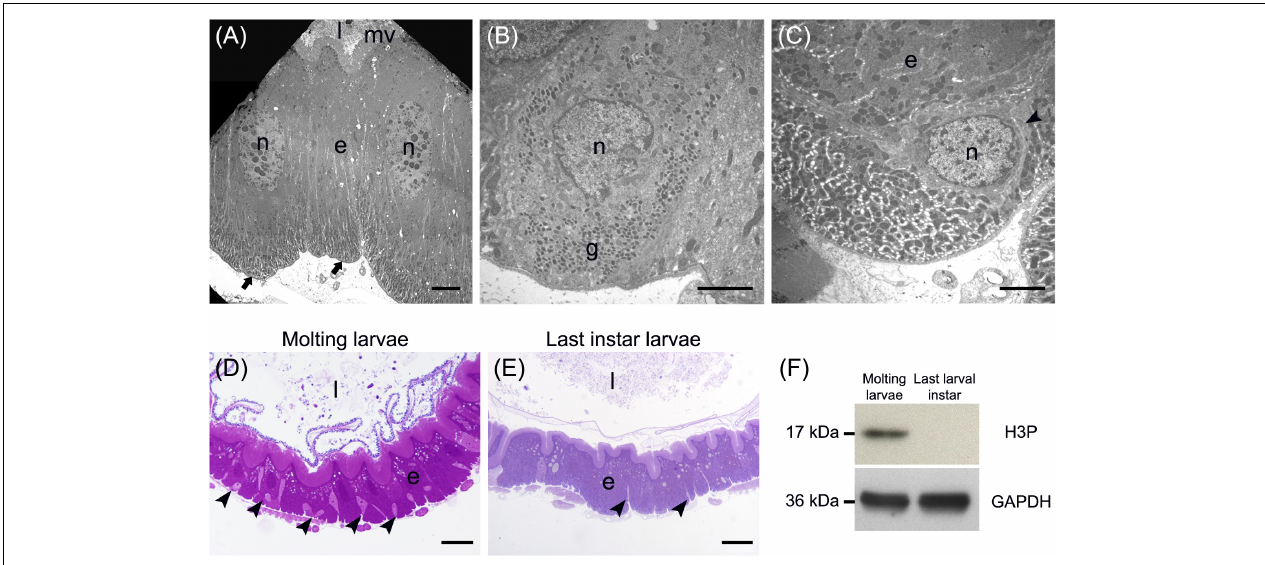
FIGURE 2 | Main cell types present in the larval midgut epithelium. (A) Columnar cells display a developed basal infolding (arrows) and long microvilli (mv). (B) Endocrine cells with electron-dense granules (g) inside the cytoplasm. (C) Regenerative cells (arrowhead) located at the base of the midgut epithelium. (D,E) The number of regenerative cells (arrowheads) increases during larva-larva molt (D) compared to the last larval instar, when the insect is actively feeding (E) . (F) Western blot analysis of phospho-Histone 3 (H3P). e: epithelium; l: lumen; n: nucleus. Bars: 5 µ m (A) , 2 µ m (B,C) , 50 µ m (D) , 20 µ m (E) .